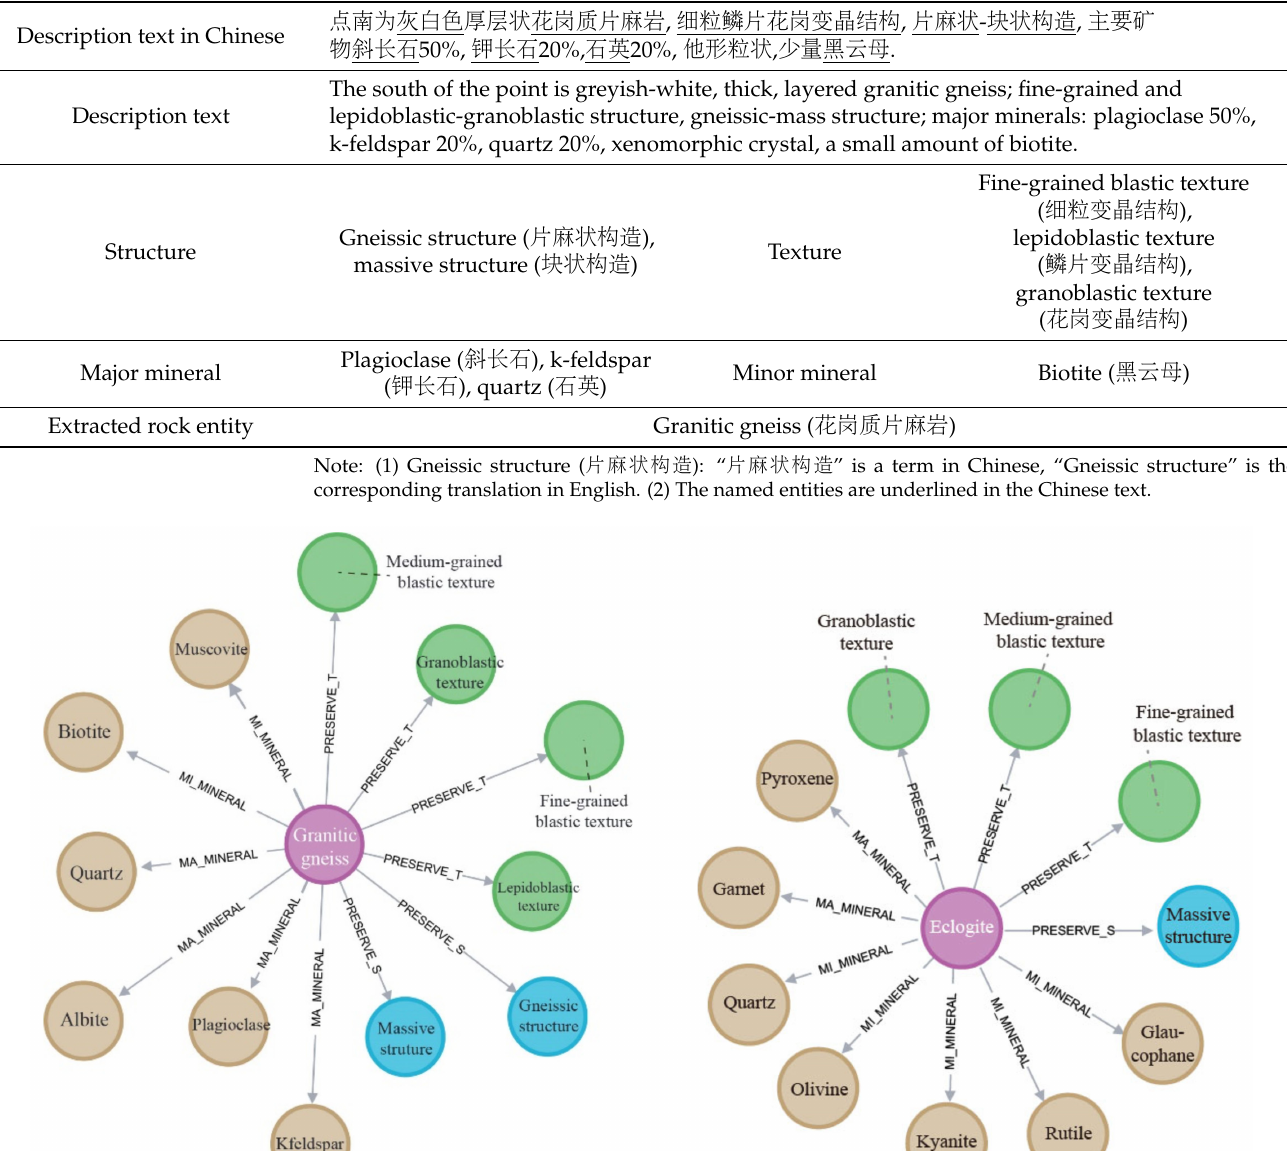
Table 2. An example of description text extraction for granitic gneiss.